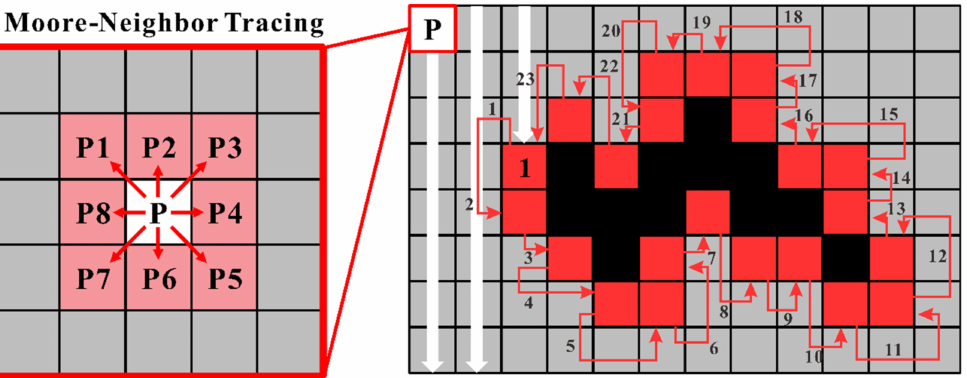
Figure 7. Visualization of implementation of Moore–Neighbor tracing algorithm with modification of the tracing termination using Jacob’s stopping criteria for grain boundary